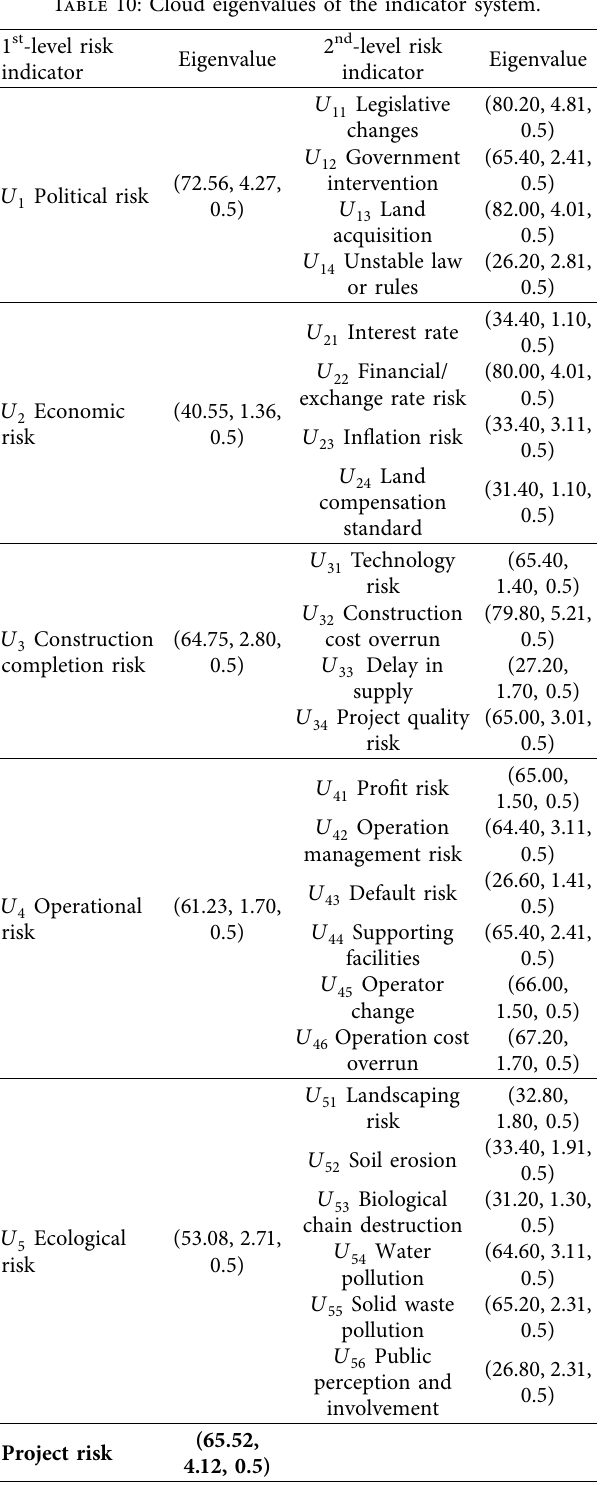
Table 10: Cloud eigenvalues of the indicator system.